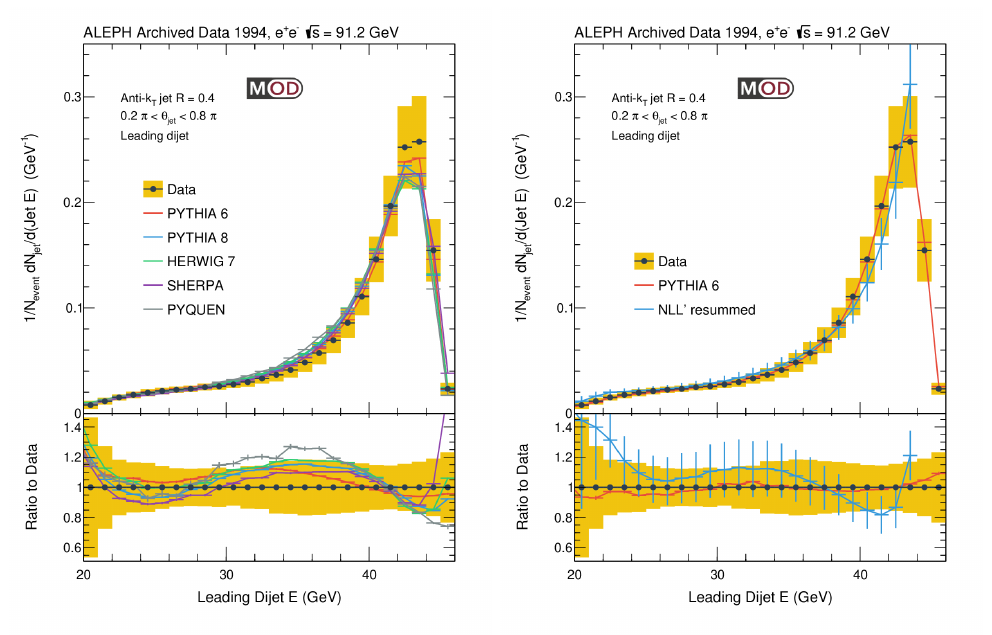
Figure 13 . Measured leading dijet jet E spectrum. The spectrum is normalized by the number of events used to perform the measurement. Any overflow contribution is included in the final bin. The data is also compared with predictions from Pythia 6 (red), Pythia 8 (blue), Herwig (green), and Sherpa (purple) generators. The predictions are normalized to have the same area as the data. (Right Panel) The data spectra are compared with pQCD calculations at NLL’+R resummation